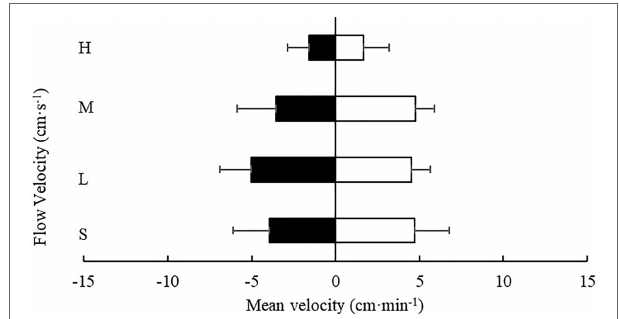
FIGURE 10 | Movement velocity of S. monotuberculatus at four water velocities in the downstream (white) and upstream zones (black) at four different flows. S, L, M, and H represent the four flow rates: 0 cm/s, 4.7 ± 1.2 cm/s, 10.5 ± 1.7 cm/s, and 20.8 ± 3.4 cm/s